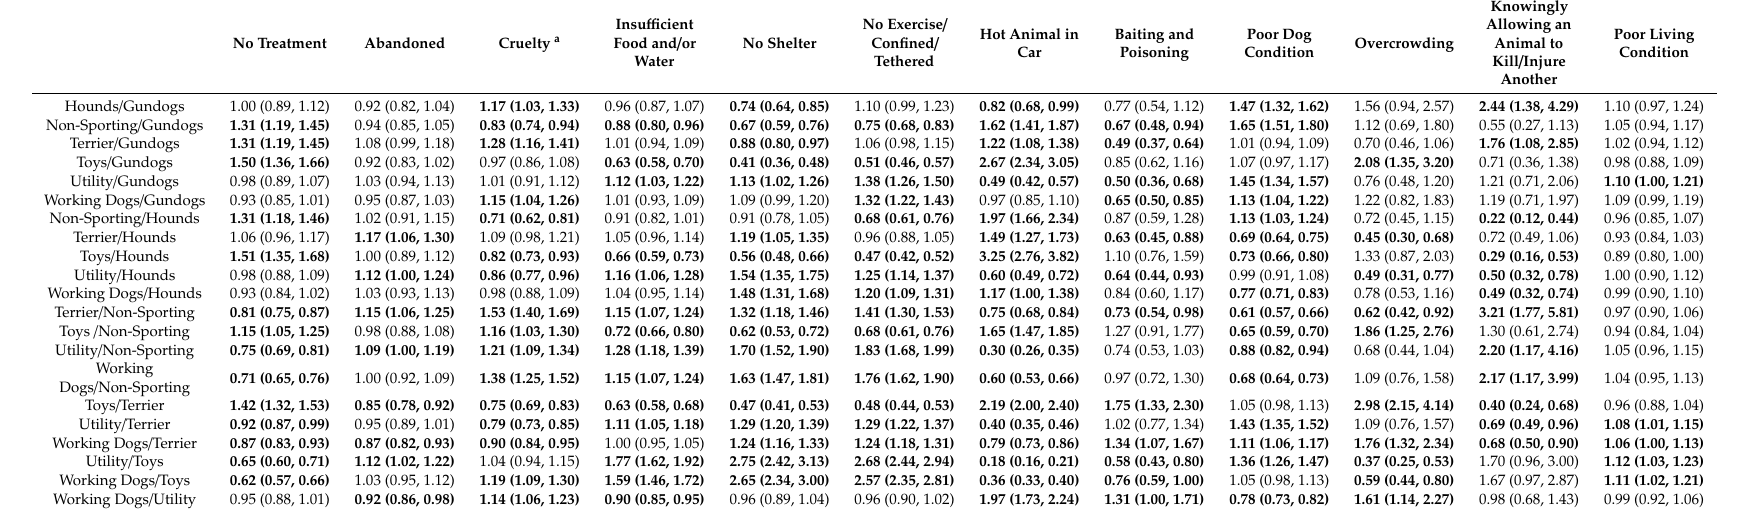
Table 4. Odds ratio and the 95% confidence interval (CI) of each breed group for every complaint code. No Treatment Abandoned Cruelty a